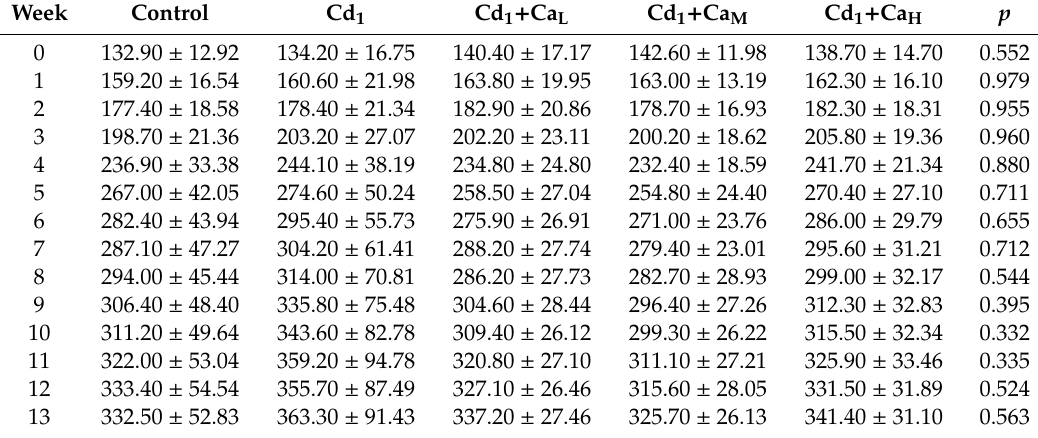
Table 2. Body weight of female rats in the 90-day oral toxicity study of Ca supplementation with dietary exposure to 1 mg Cd / Kg (Exp. 1).